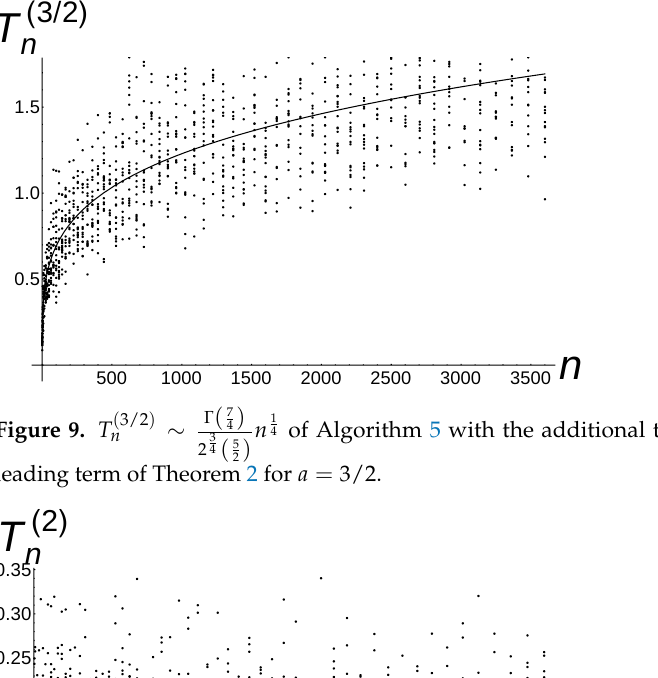
Figure 8. T term of Theorem 2 for a = 1.